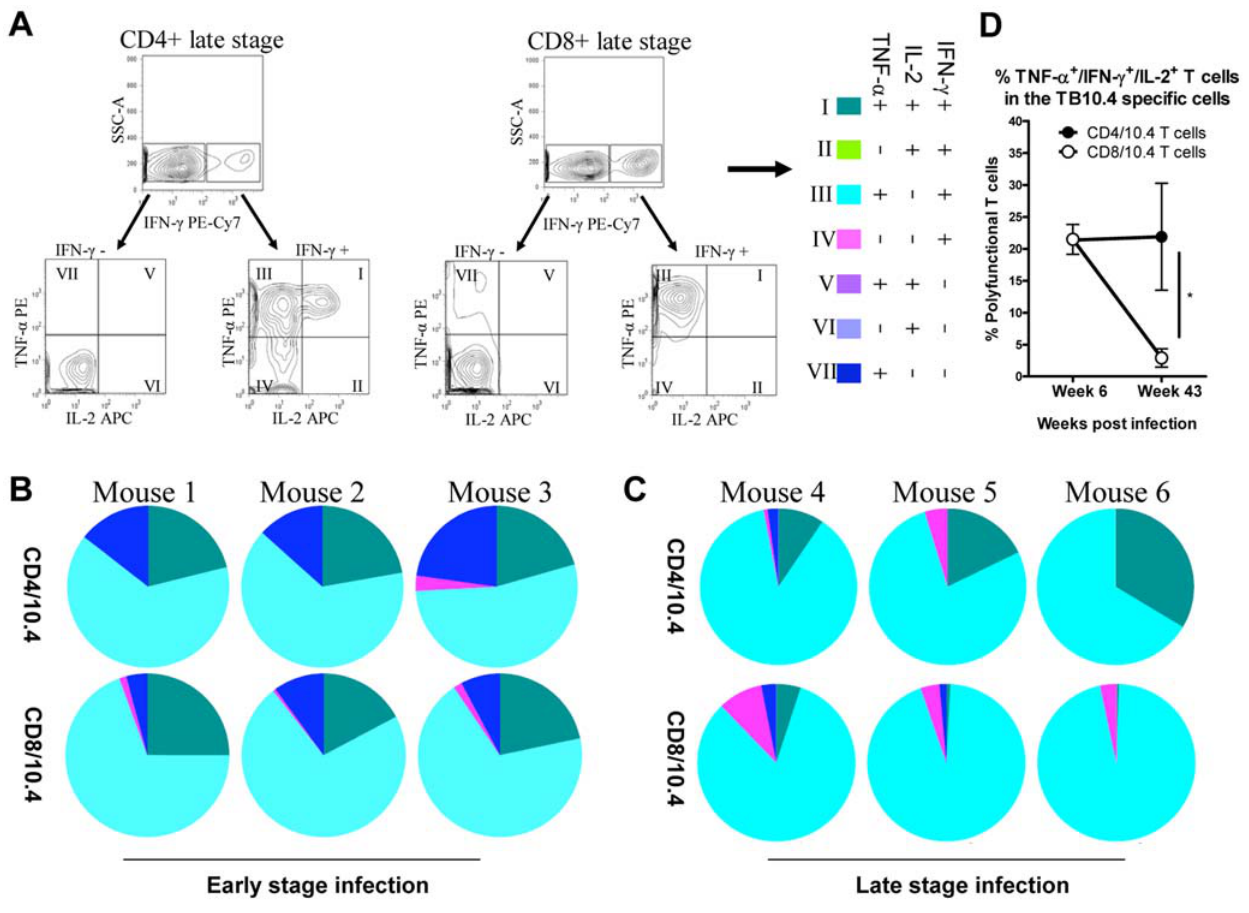
Figure 5. Changes in cytokine profiles of CD4/10.4 and CD8/10.4 T cells during a chronic infection. Cells from infected lungs were stimulated with TB10.4 3–11 or TB10.4 74–88 prior to staining with anti-CD4, -CD8, -IFN- c , -TNF- a and –IL-2. (A) Cytokine profiles of CD4/10.4 was determined by first dividing the CD4 T cells into IFN- c positive ( + ) or IFN- c negative ( 2 ) cells. Both the IFN- c + and IFN- c - cells were analyzed with respect to the production of TNF- a and IL-2. The numbers in the quadrant gates of the plots denominates each distinct population based on their cytokine production and is color coded as shown. To illustrate the gating sequence two examples from a late infection stage are shown. (B and C). The pie-charts illustrate the relative contribution of the different cytokine T cell populations to the total CD4/10.4 population and data is depicted for both an early and a late time point, for 3 mice at each time point. Background ( . 0.5%) has been deducted. (D) The proportion of IFN- c + TNF- a + IL-2 + within the CD4/10.4 or CD8/10.4 T cells populations in the early stage compared to the late stage of